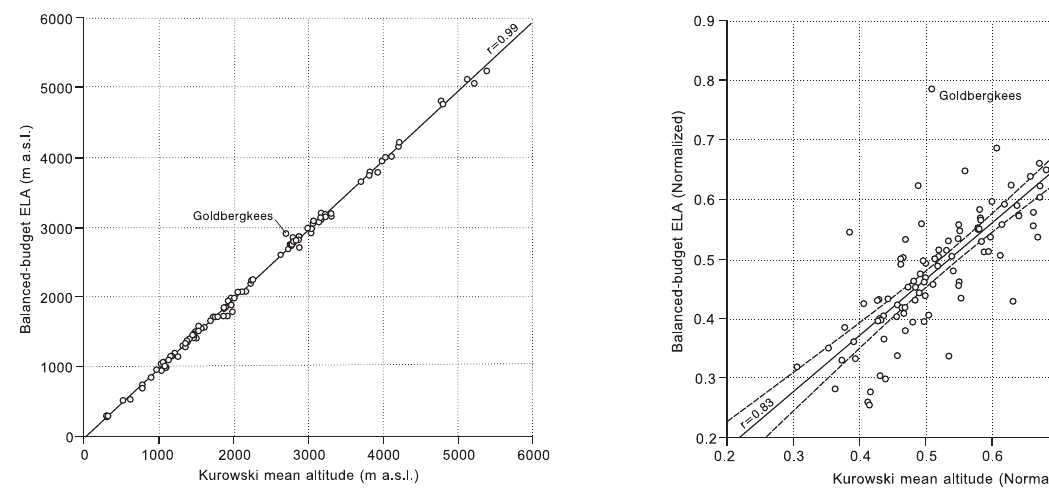
Figure 6. Balanced-budget ELA vs. Kurowski’s mean altitude for 103 glaciers with both variables normalized to the altitude range of the glaciers. The normalization of each variable involves subtrac- tion of H min and division by (H max – H min ) . Dashed lines denote 95% confidence interval around the regression line according to Student’s t -statistic.